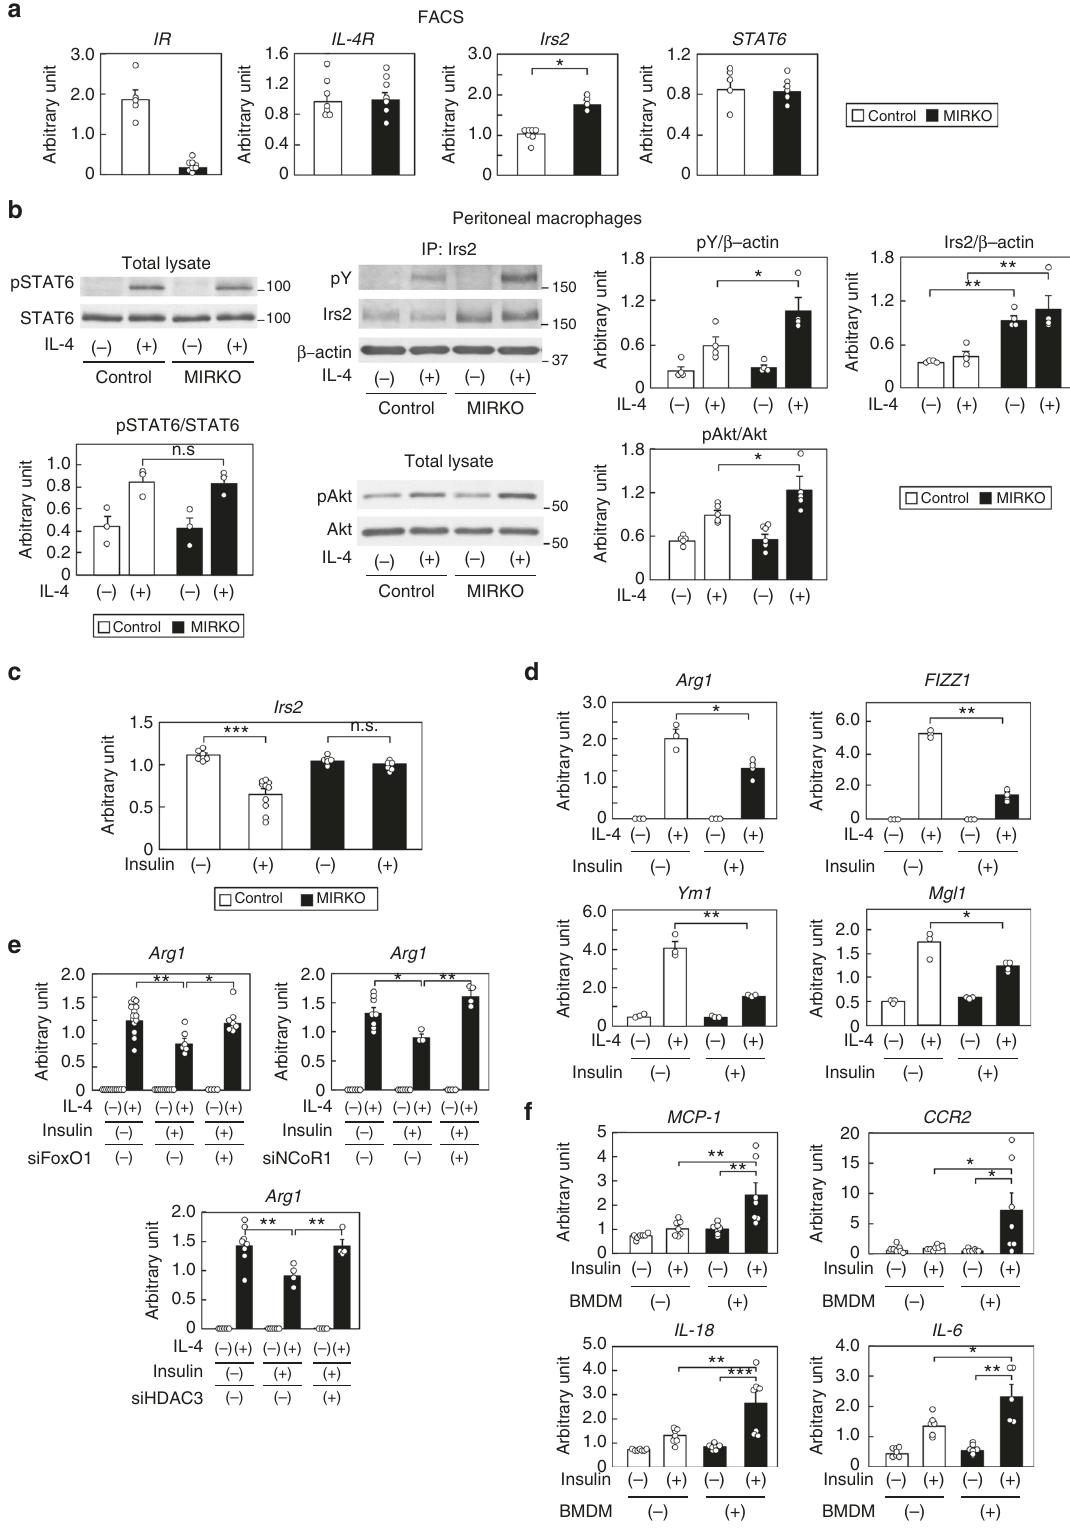
Fig. 5 The Irs2 mRNA levels and number of M2a-subtype M Φ s were elevated in HF diet-fed M IR KO mice. a Expression levels of IR , IL-4R , Irs2 and STAT6 in the siglecF - CD11b + F4/80 + cells of the SVF of the adipose tissue from the control and M IR KO mice ( n = 4 – 6). b IL-4-induced STAT6, Irs2 and Akt phosphorylation in peritoneal M Φ s of HF diet-fed M IR KO mice ( n = 3 – 6). c Irs2 expression levels in the BMDM of the control and M IR KO mice after